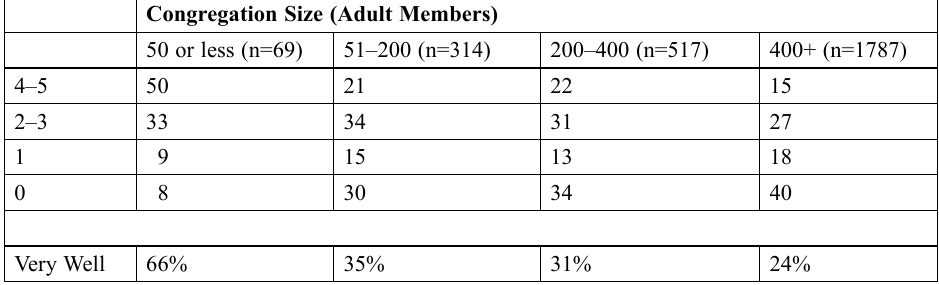
Table 2: Questions to congregations in Northern California 1963: ‘Of your fi ve closest friends, how many are members of your congregation?’ and ‘All in all, how well do you think you fi t with the group of people who make up your congregation?’ (after Stark and Finke 2000, Table